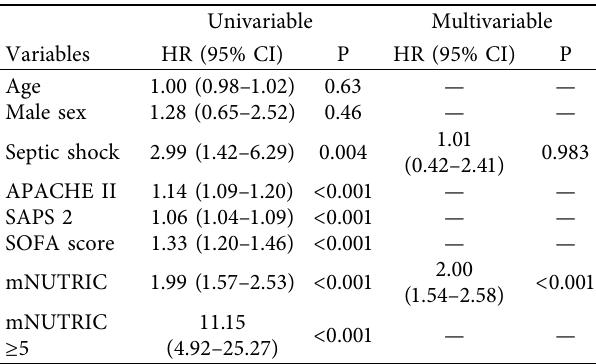
Table 4: Univariate and multivariate analysis of in-hospital mortality in